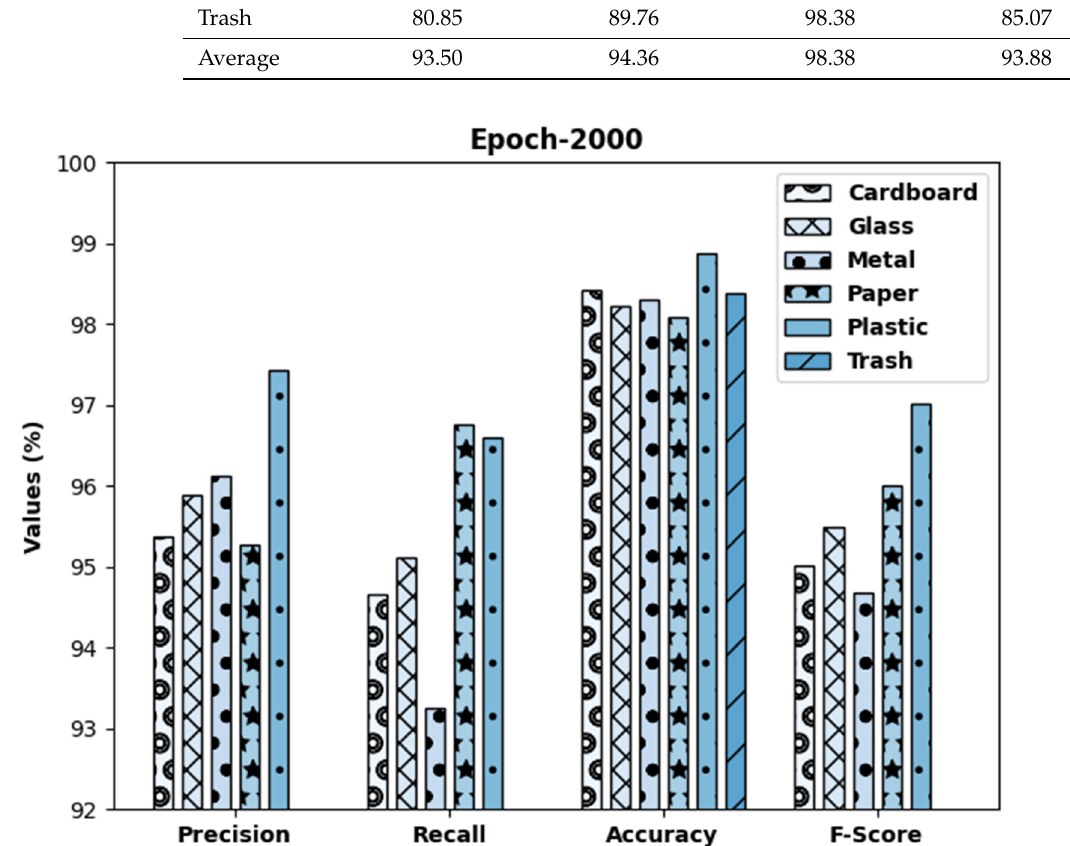
Figure 10. Result analysis of DLSODC ‐ GWM technique under 2000 epochs.